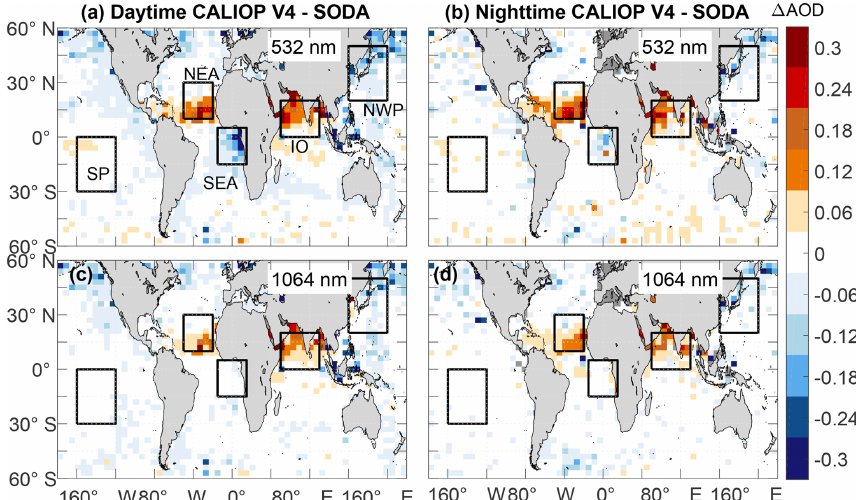
Figure 4. Mean AOD difference between CALIOP V4 and SODA for 5 months of 2010 for daytime (a, c) and nighttime (b, d) and the 532nm (a, b) and 1064nm (c, d) channels. Boxes denote specific regions in which the extinction coefficient profiles are further compared in Fig. 5: South Pacific (SP), southeast Atlantic (SEA), Indian Ocean (IO), northeast Atlantic (NEA) and northwest Pacific (NWP).